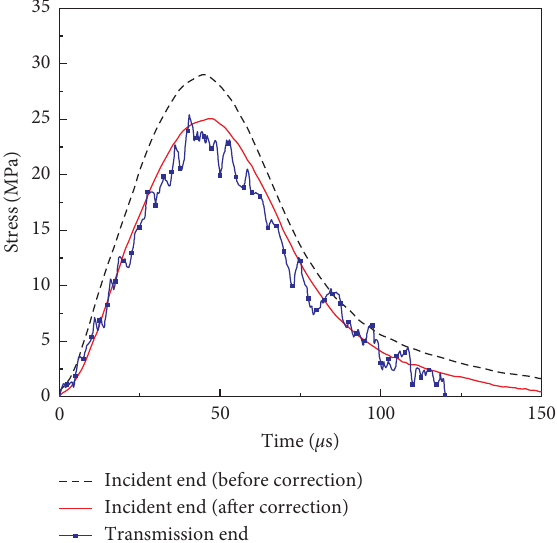
Figure 10: Comparison of stress calculated from elastic theory and viscoelastic